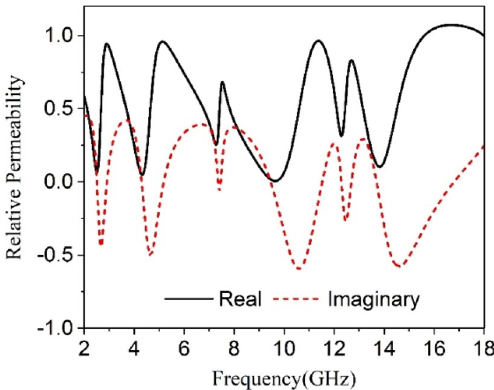
Figure 17. Real and Imaginary part of relative permeability.